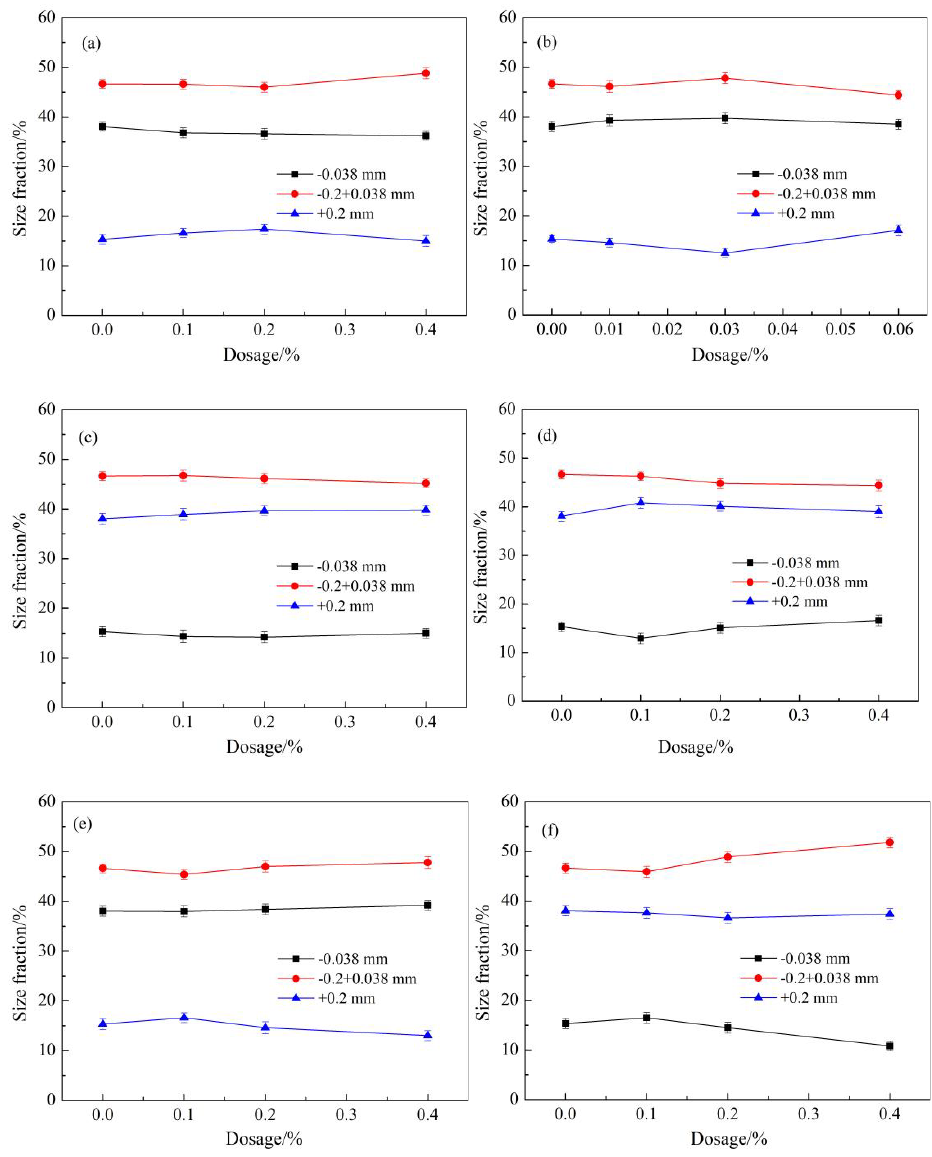
Figure 1. The plots of the yields of product size fractions against the dosage of ( a ) sodium hexameta- phosphate, ( b ) triethanolamine, ( c ) ferric sulphate, ( d ) aluminum chloride, ( e ) polyaluminum chloride and ( f ) PAM300.